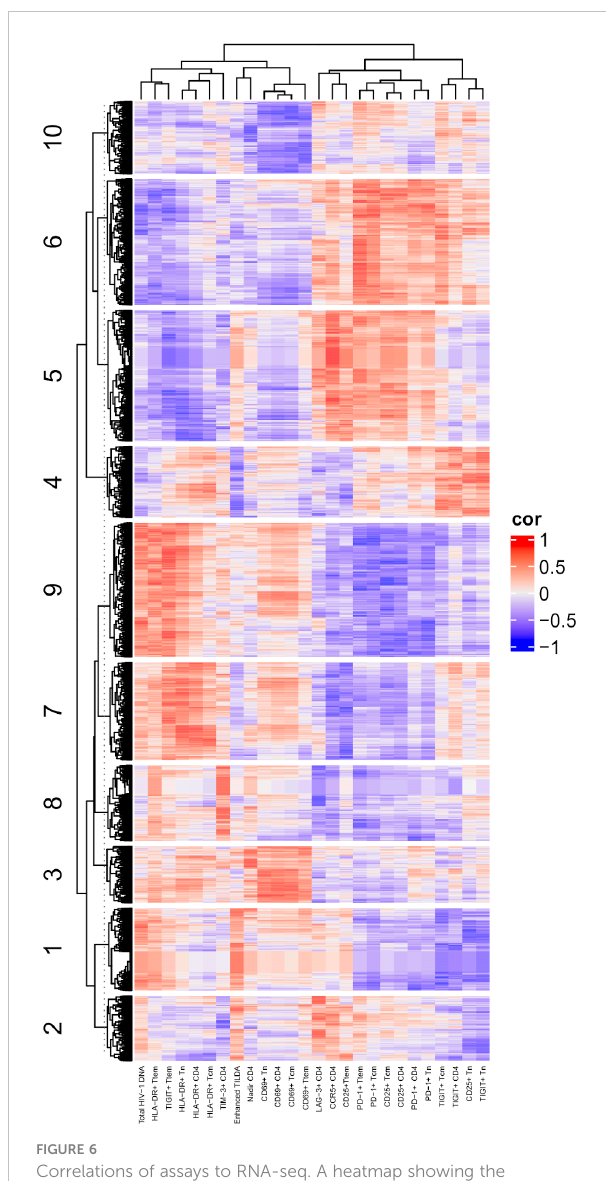
FIGURE 6 Correlations of assays to RNA-seq. A heatmap showing the Spearman ’ s correlations between RNA-seq and assay measurements are presented. DVS, Duration of virologic Suppression. In the heatmap, each row represents a gene, and each column represents an assay. Only genes with absolution correlation larger than 0.75 with at least one assay were shown. The genes were grouped into 10 clusters based on K-mean clustering and the cluster IDs were indicated in the